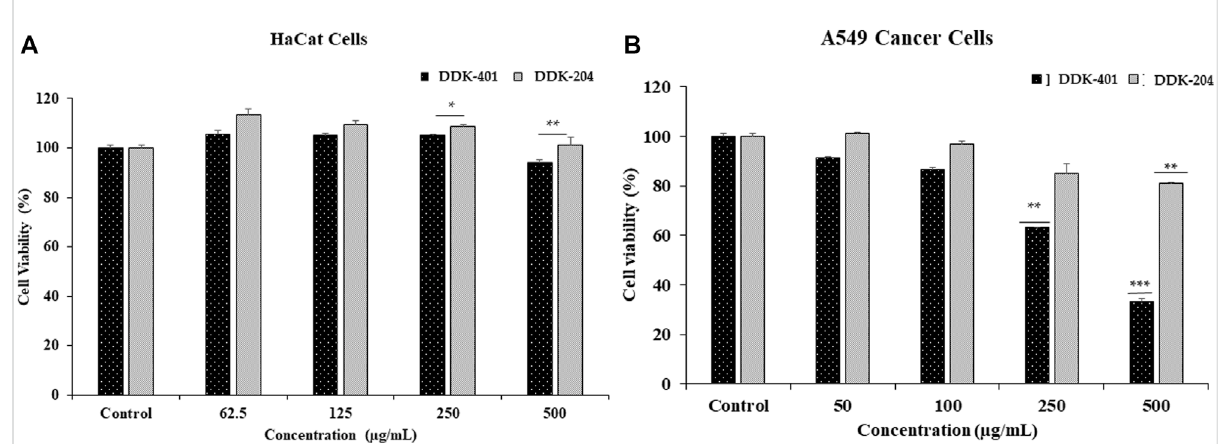
FIGURE 5 Invitro cytotoxicitiesofDDK-401andDDK-204samplesin (A) HaCaTand (B) A549lungcancercellsover24 h.Thegraphshowsthemean±SD value of four repetitions. ** p < 0.01; *** p < 0.001 indicate signi fi cant differences from the control groups.